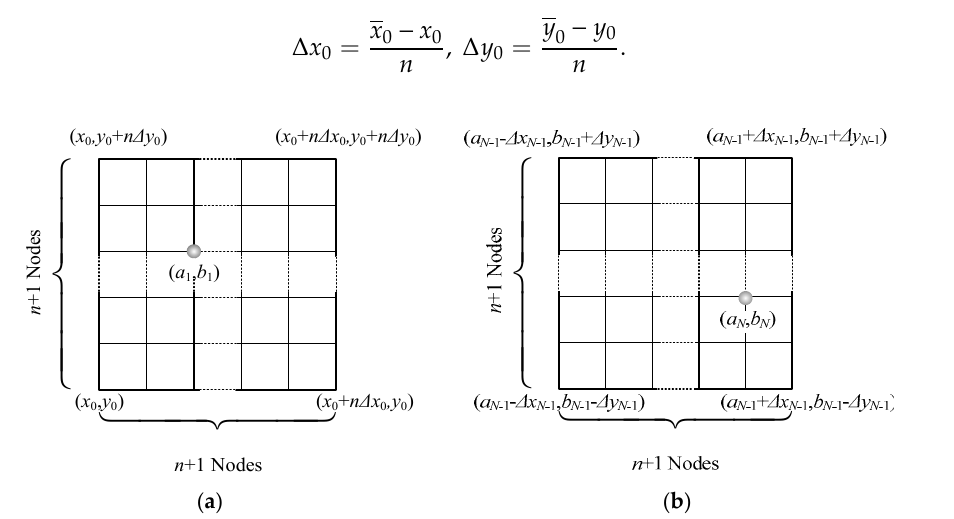
Figure 2. Steps of the MMA method. ( a ) First loop step, ( b ) N th loop step